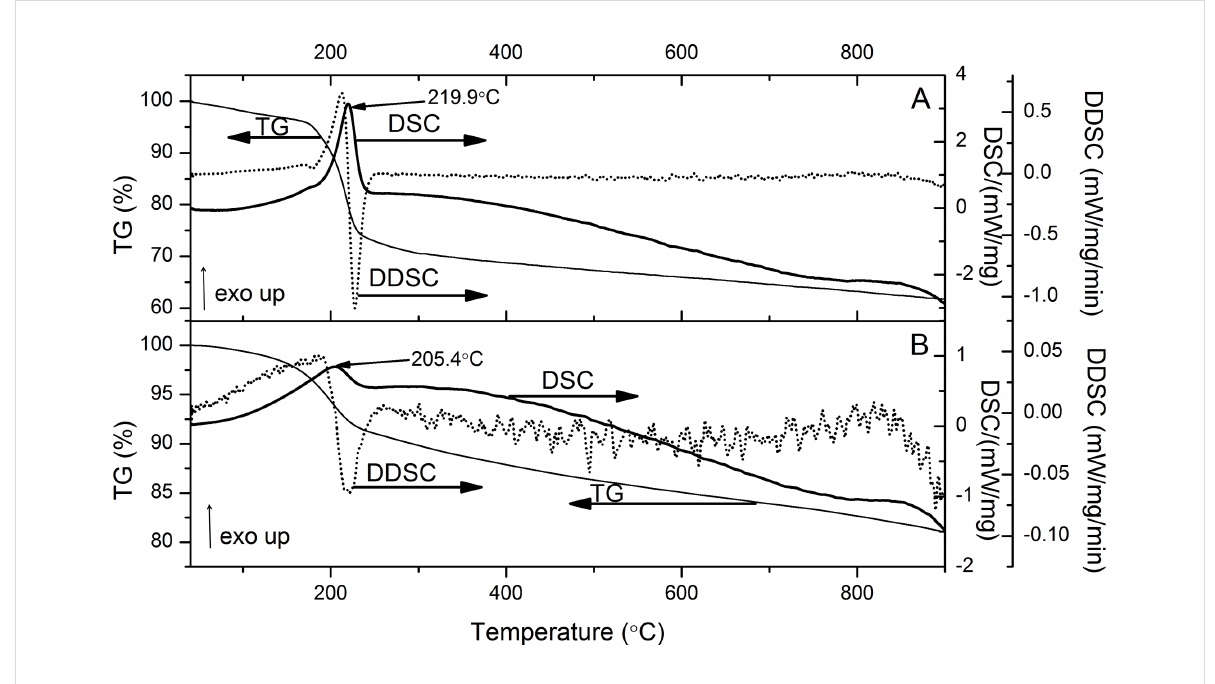
Figure 9: DSC and DDSC curves of A) GO sample and B) GO-P. The TG curves are the same as in Figure 8.